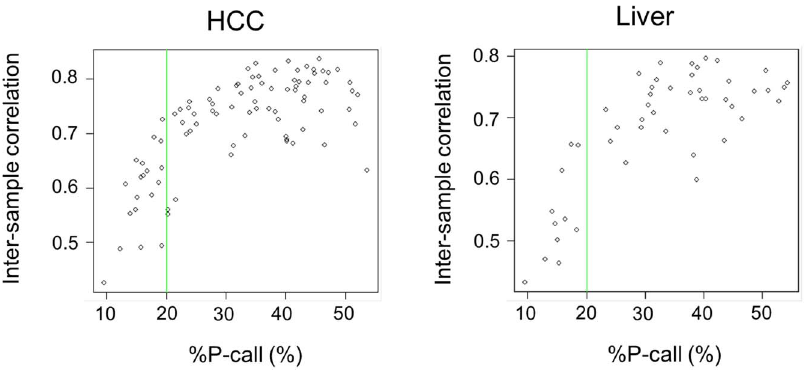
Figure 3. Quality of genome-wide transcriptome profiles of (A) AS-FFPE HCC and (B) liver cirrhosis tissues. Inter-sample correlation is plotted against %P-call. Green lines indicate quality cut-off of %P-call (20%). AS: archived section, FFPE: formalin-fixed paraffin-embedded, HCC: hepatocellular carcinoma, %P-call: % present call.